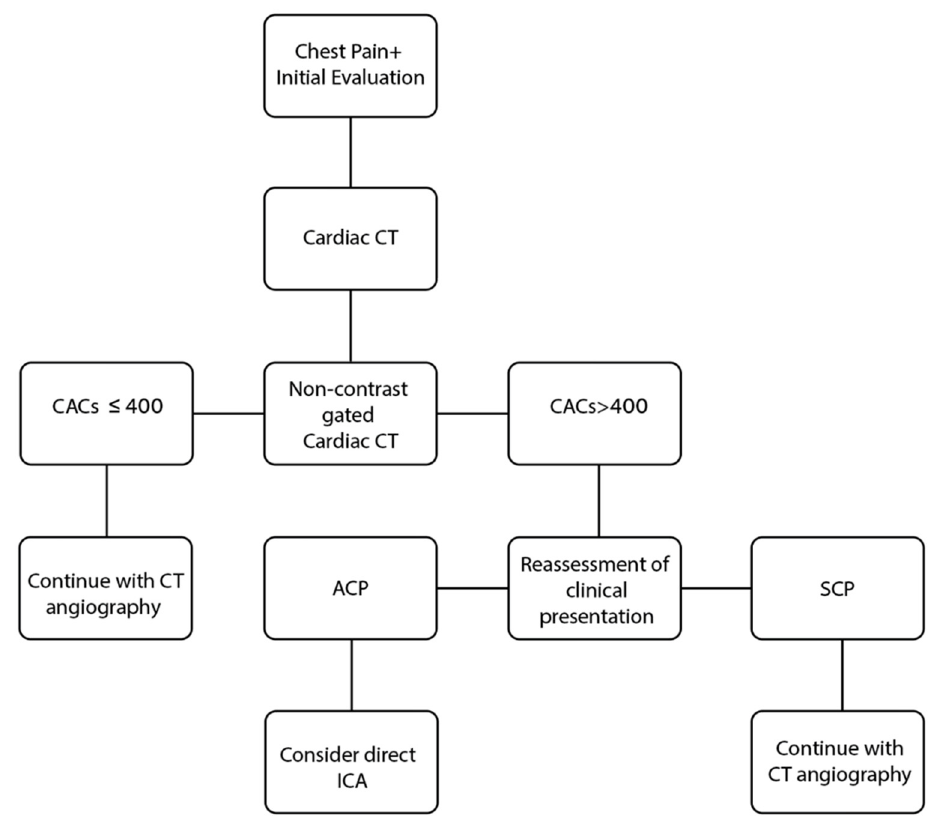
Figure 5. Proposed algorithm for the evaluation of chest pain along with negative cardiac biomarkers and negative findings on ECG. ACP: acute chest pain, CACS: coronary artery calcium score, ECG: electrocardiogram, ICA: invasive coronary angiography, SCP: stable chest pain.